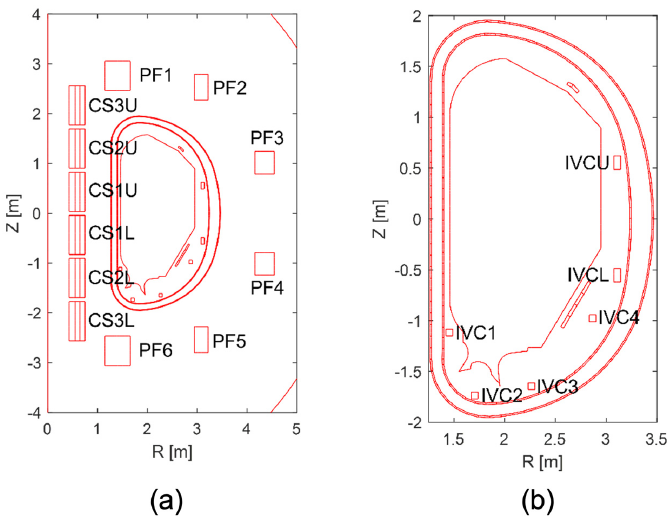
Figure 1. Magnetic coils system of a DTT device: ( a ) CS/PF coils of DTT; ( b ) In-vessel coils of DTT.